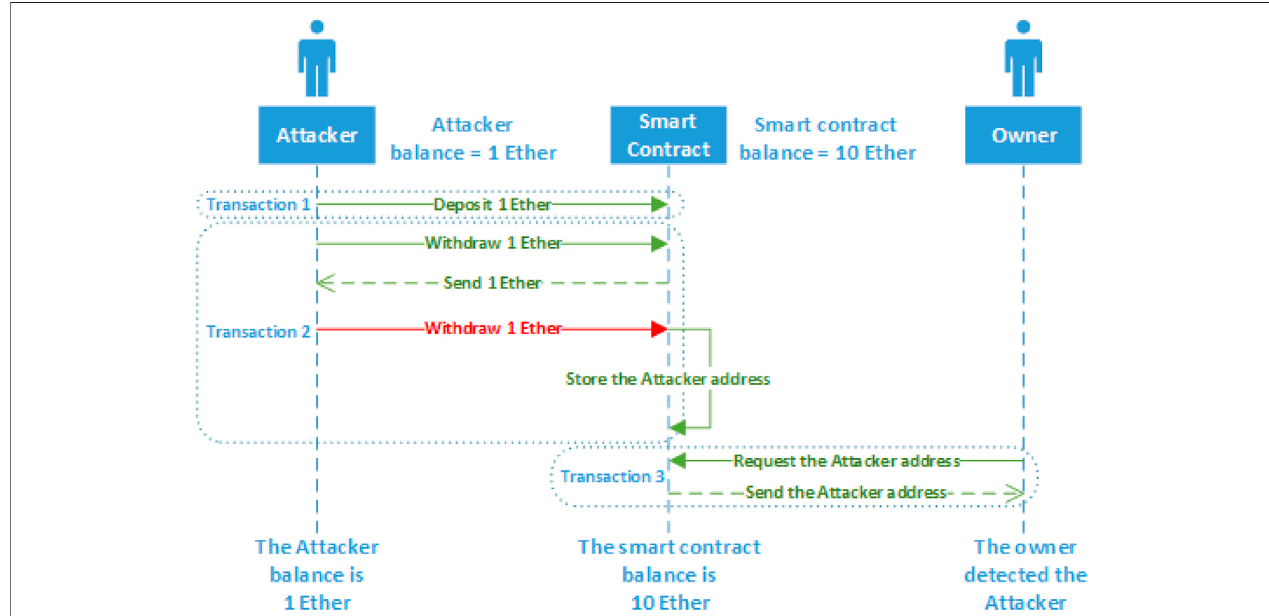
FIGURE 9 | UML sequence diagram for the second scenario in the fi rst case study.